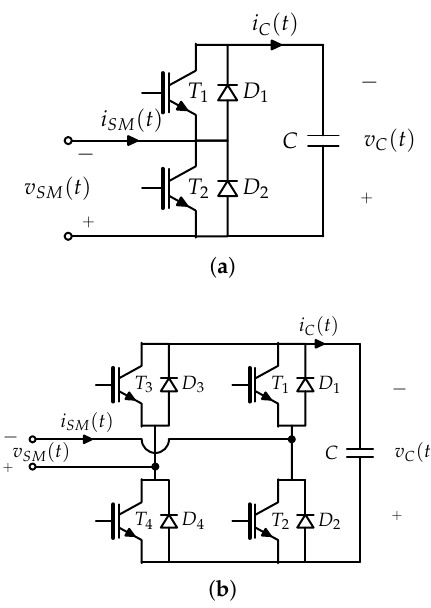
Figure 2. MMC submodule. ( a ) half bridge; ( b ) full bridge. Table 1. Operation of half bridge